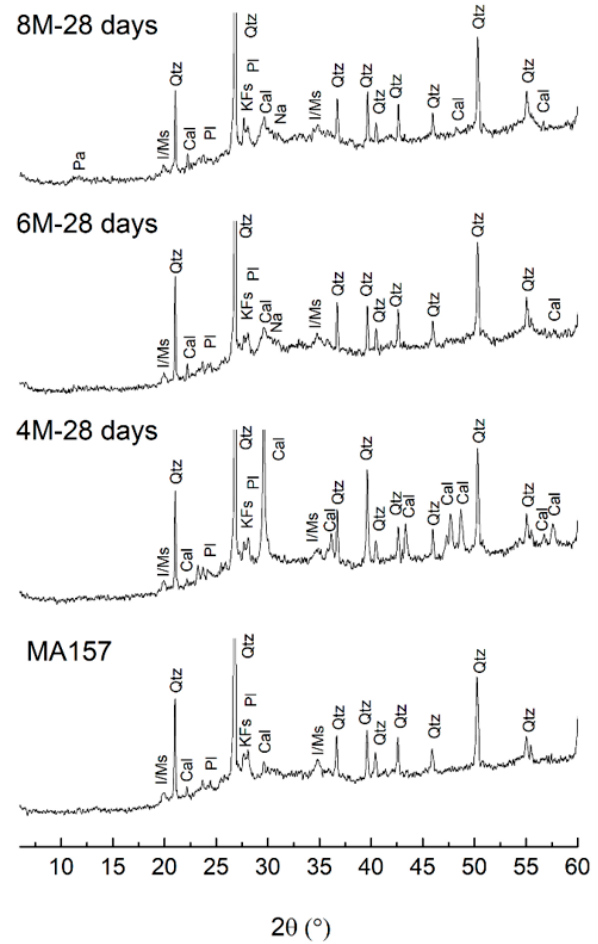
Figure 3. XRD patterns for anhydrous MA157 clay and 28 days, 4, 6 and 8 M NaOH-activated pastes Legend: I/Ms = illite/muscovite; Qtz = quartz; Pl = plagioclase, Kfs = K-feldspar, Cal = calcite; Na = natron; Pa = para-alumohydrocalcite/hemicarboaluminate.